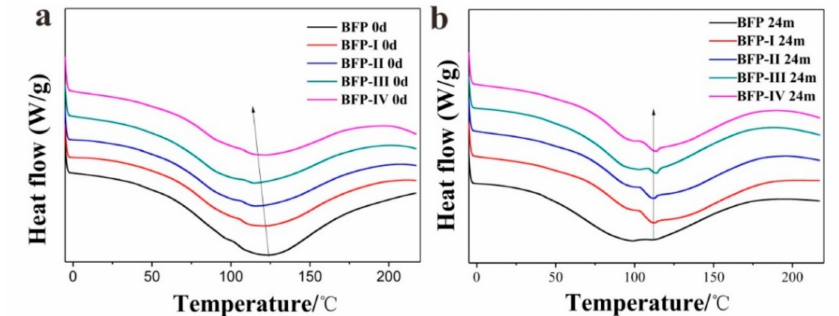
Figure 7. DSC curves of before ( a ) and after ( b ) degradation of BFP, BFP-I, BFP-II, BFP-III, and BFP-IV